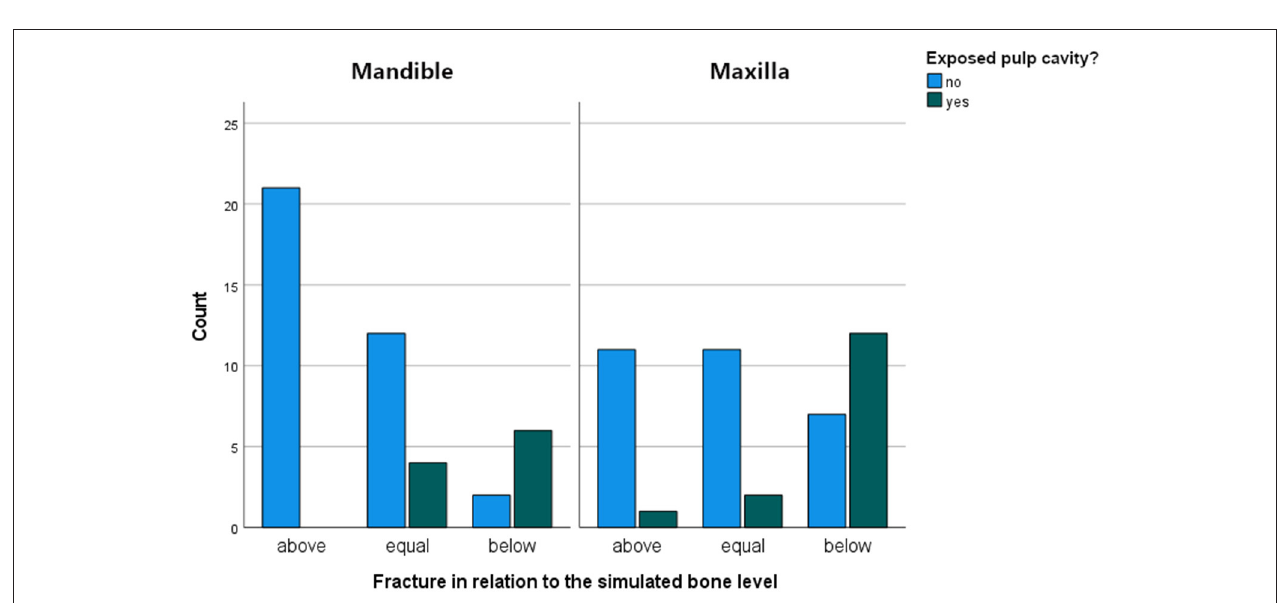
FIGURE 6 | Bar chart illustrating the number of cases with exposed pulp cavities in relationship to the fracture level in the mandibular and maxillary cheek.